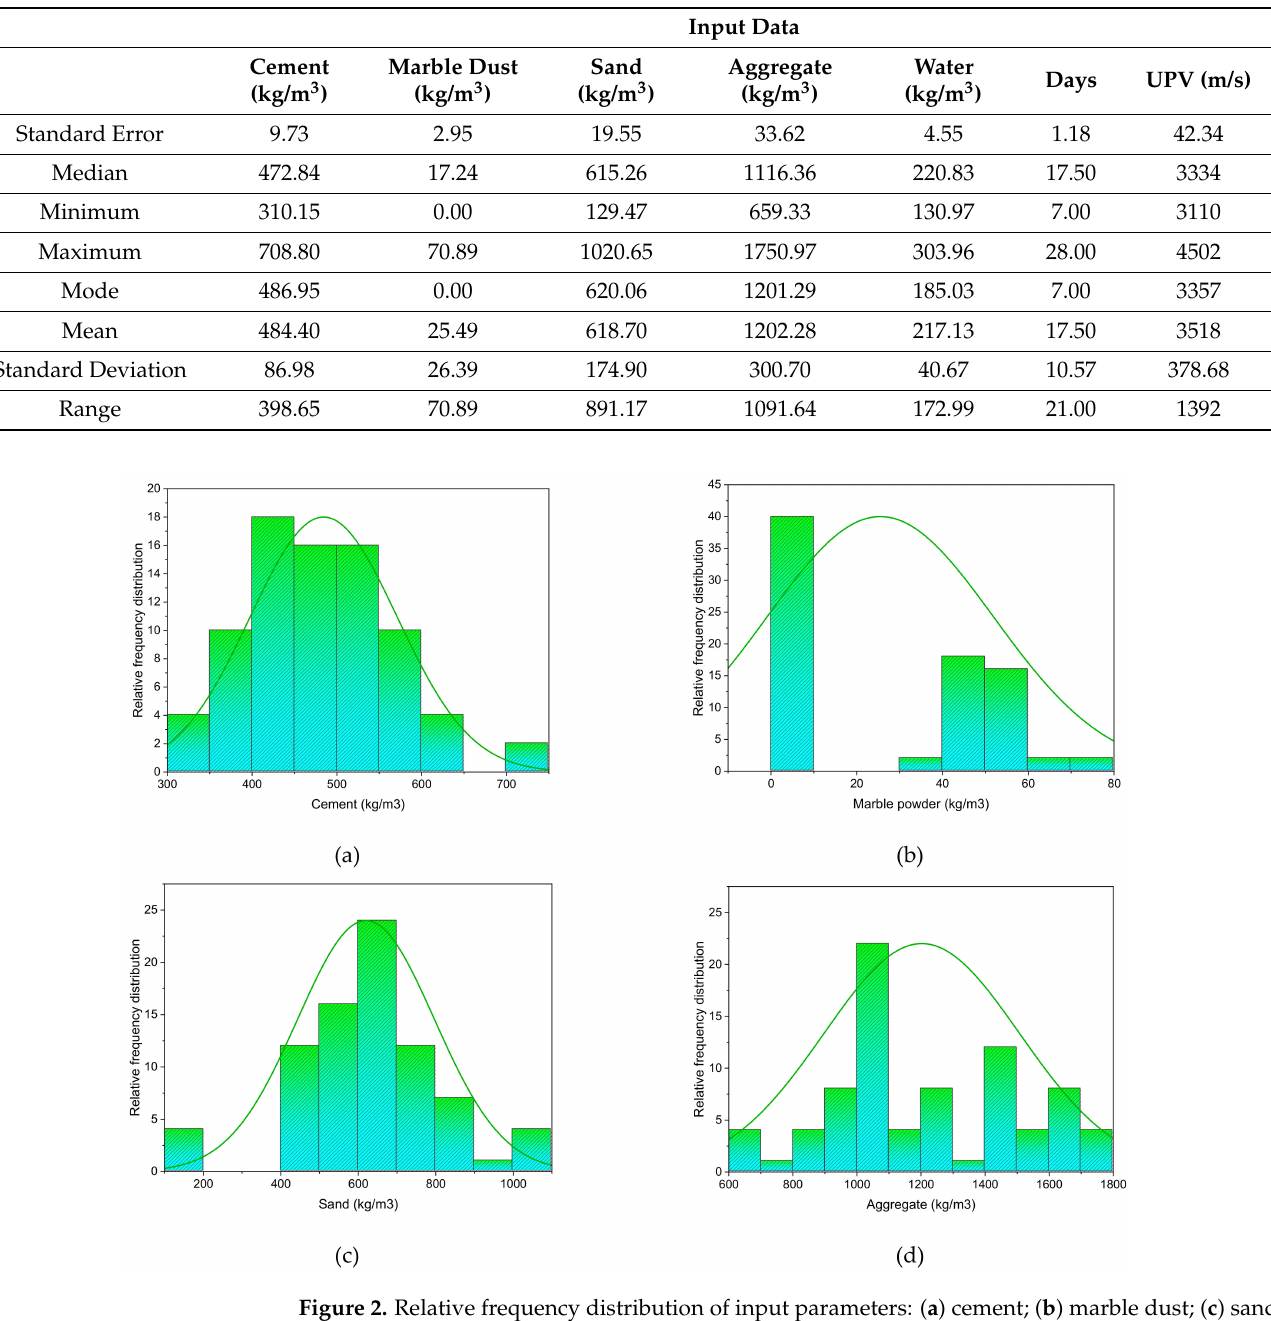
Figure 2. Relative frequency distribution of input parameters: ( a ) cement; ( b ) marble dust; ( c ) sand; and ( d ) coarse